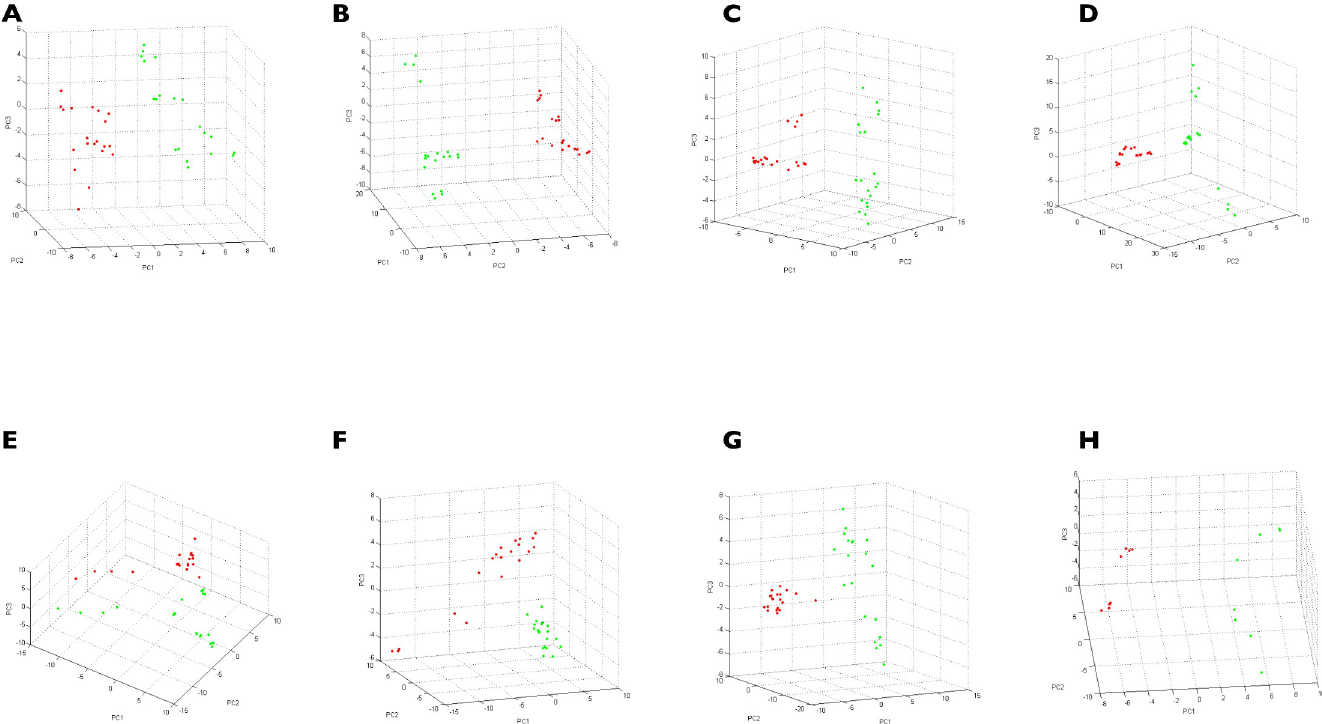
Fig 4. Assessment of MS spectra specificity according to species and body parts using principal component analysis. MS spectra from the legs and half–idiosoma of ticks were analyzed by species using the PCA tool. Red dots represent spectra of the four legs and green dots represent spectra of the half–idiosoma. (A) D . reticulatus (B) I . acuminatus (C) I . persulcatus (D) I . ricinus (E) I . scapularis (F) I . uriae (G) I . ventalloi (H) I . vespertilionis .